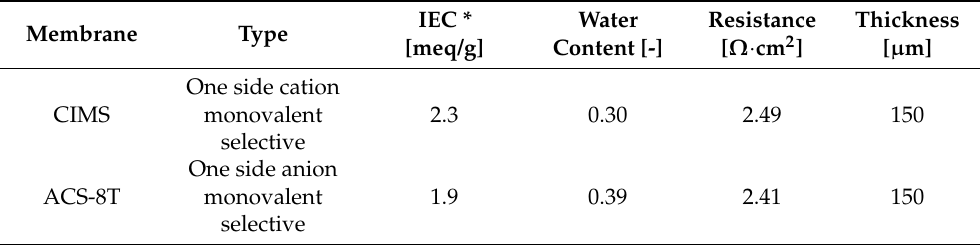
Table 2. Properties of ASTOM’s ion exchange membranes applied in RED